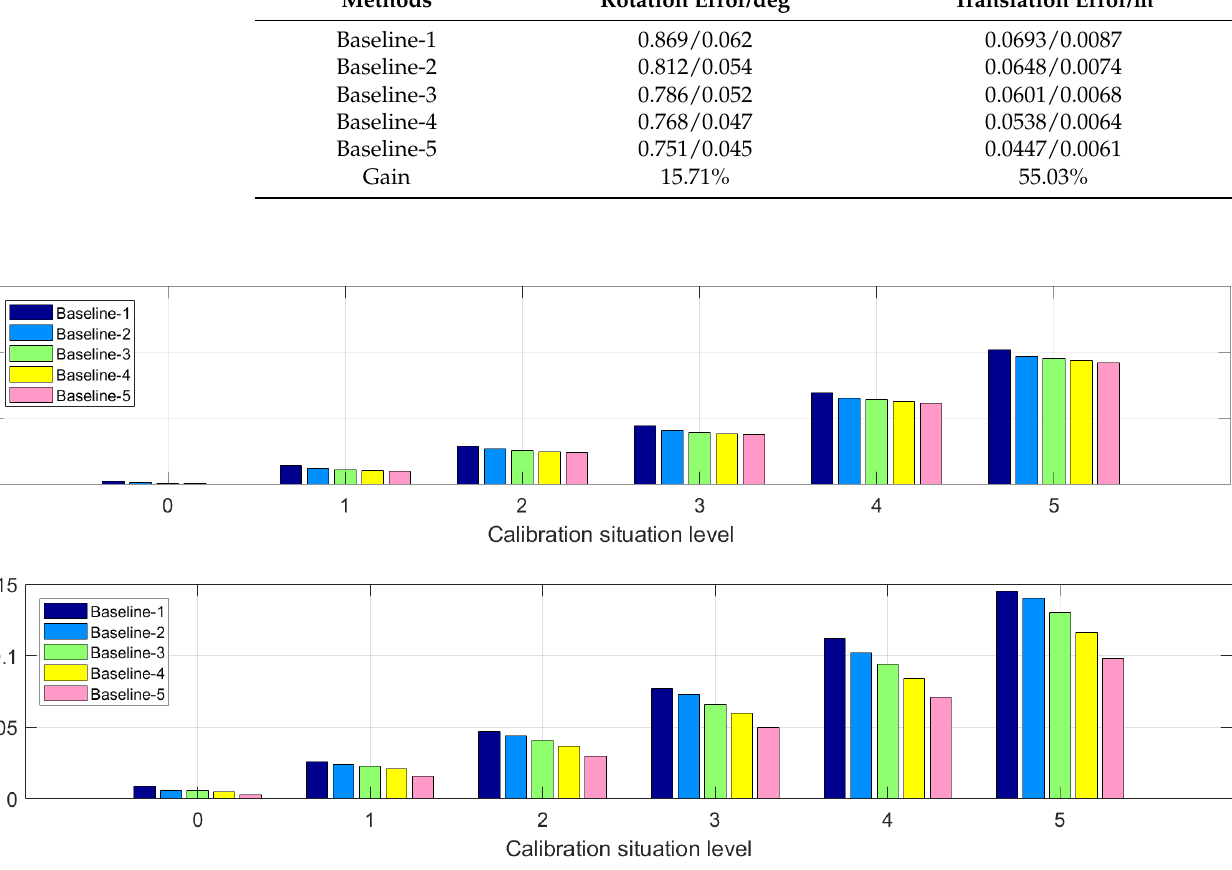
Figure 6. Calibration performance of five baseline methods in the validation